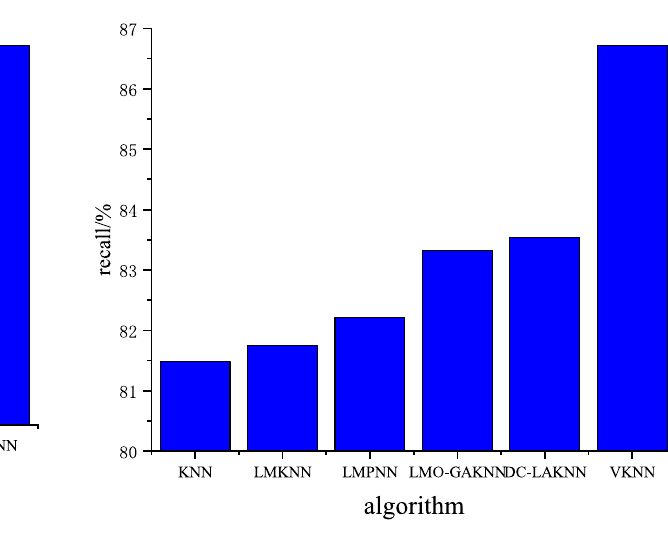
Fig. 2 Average accuracy of different algorithms